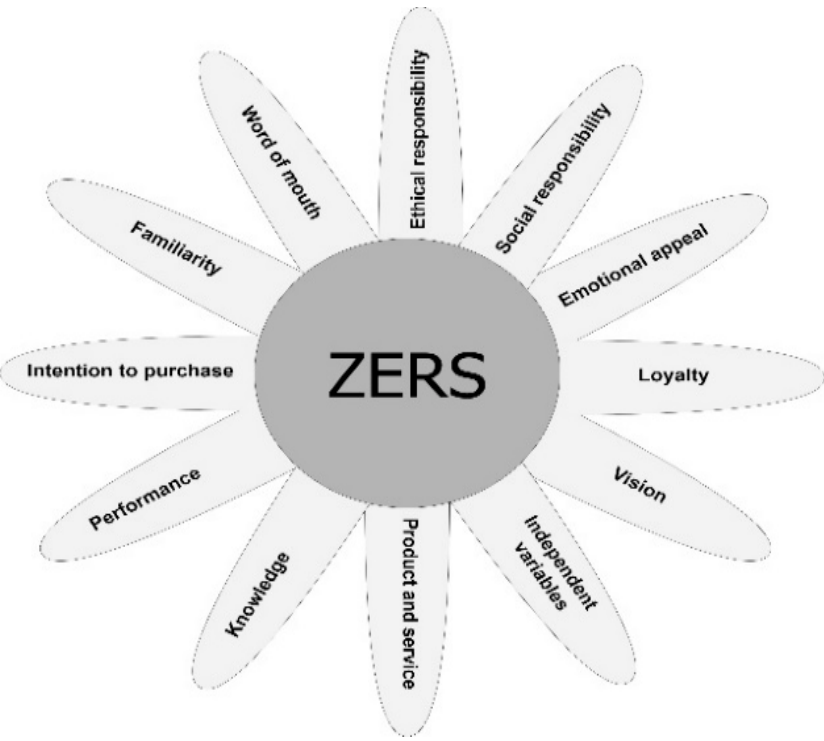
Figure 3. ZERS outline shows the drivers influencing the reputation of a zoo analyzed in the